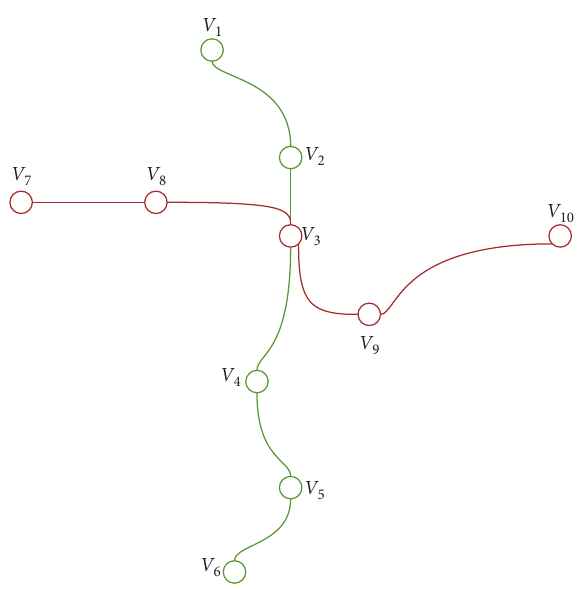
Figure 1: A sample of an urban rail transit